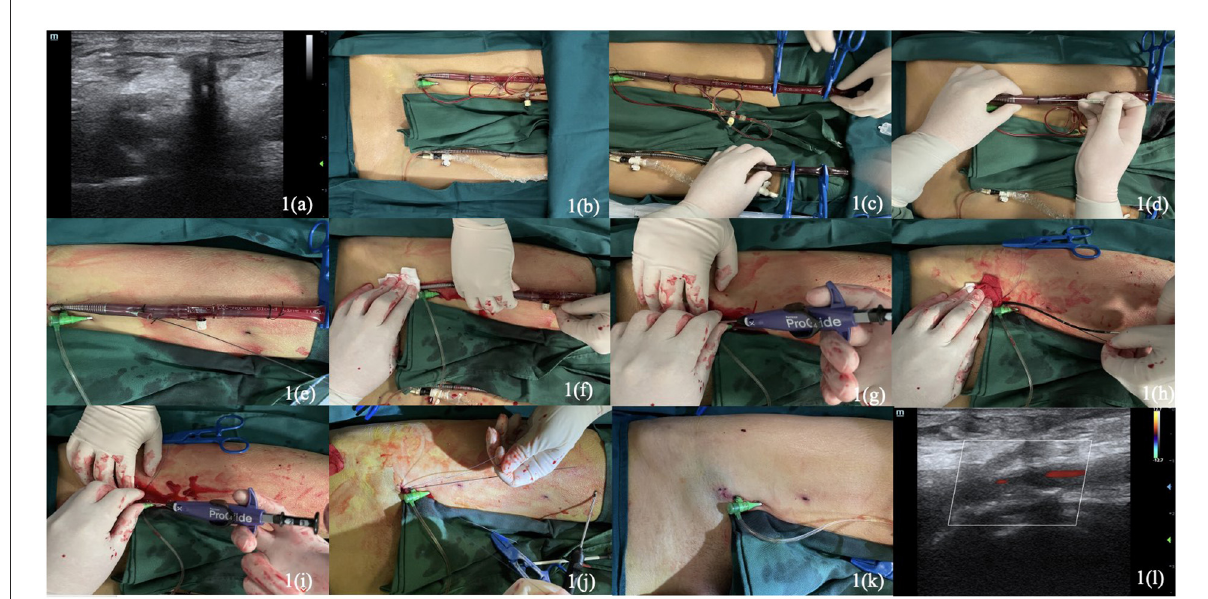
FIGURE1 Pre-operative ultrasound images (a) . Sterile preparation of the operative area (b) . The clamping of arterial and venous cannulas at the distal part by four tubing clamp forceps (c) . Direct puncture with seldinger technique in the proximal portion of the arterial cannula (d) . The insertion of Terumo Stiff guidewire through the cannula (e) . Removal of the arterial cannula under manual compression at the access by an assistant (f) . Insertion of the first Perclose Proglide and deploying at the direction about 10–11 o’ clock (g) . Removal of the first Proglide and placement a clamp forcep to hold the two suture limbs together on the right side of the patient (h) . Reinsertion of the guidewire to place the second Proglide and deploy at about 1–2 o’ clock (i) . Wrapping the railed suture limbs tightly around the left index finger to pull it (j) . The hemostasis was adequate and cut the suture tails (k) . Post-operative ultrasound images with normal blood flow of femoral artery (l)